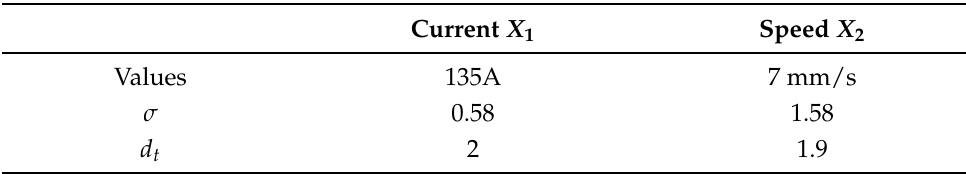
Table 1. Process parameters to disturb the sample